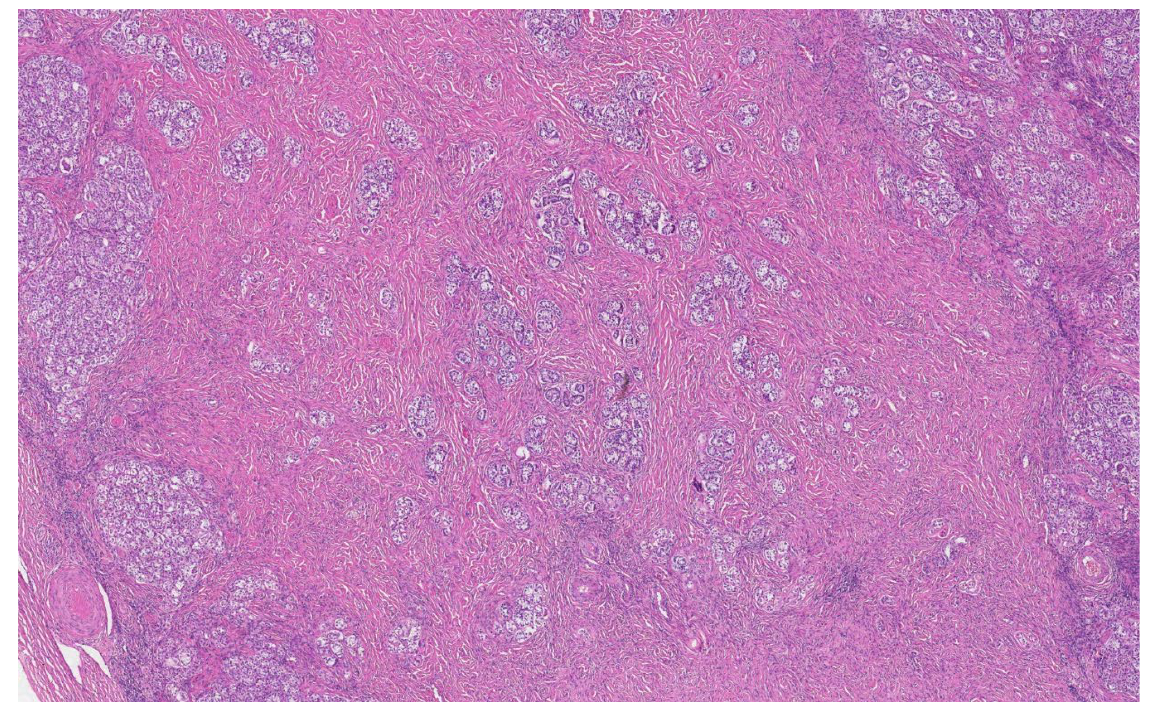
Figure 6. One of the testes revealed a nodule composed of spindle cells, abundant collagen fibers and tubular structures lined by Sertoli cells (H&E staining, ×40).